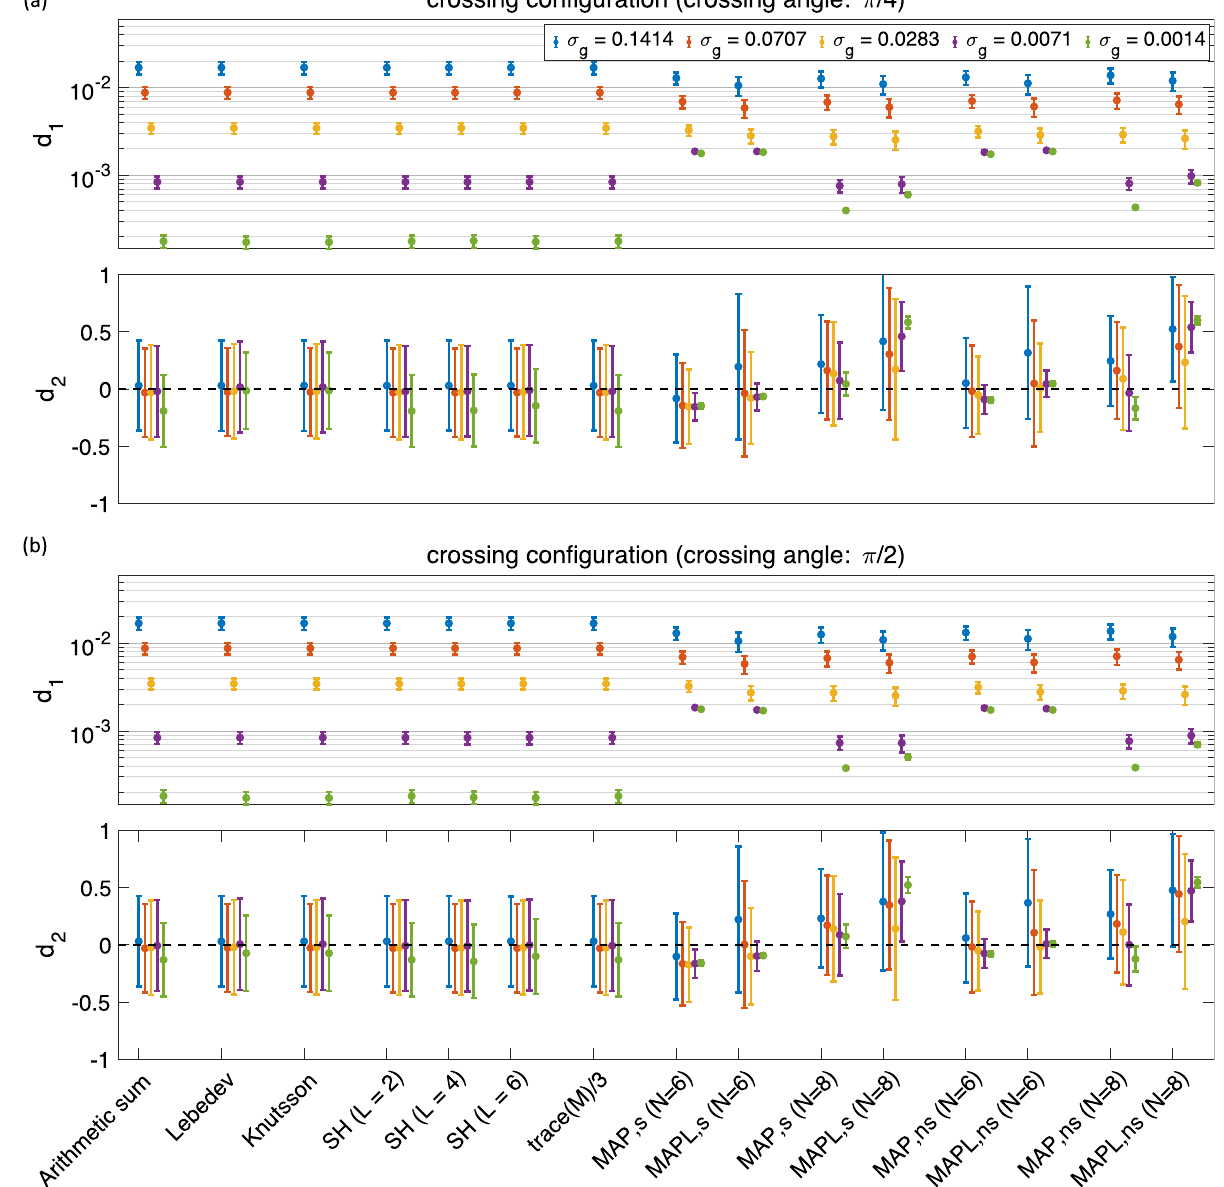
Figure 4. The mean and std of the d 1 and d 2 measures using different methods for 344 samples in the presence of crossing configuration with ( a ) π/ 4 and ( b ) π/ 2 radians crossing angle (the y-axis in d 1 is scaled logarithmically). The ‘s’ and ‘ns’ correspond to the shelled and non-shelled point sets, respectively. Different colors (blue, red, yellow, purple, green) show the results in different noise levels 0.1414, 0.0707, 0.0283, 0.0071, 0.0014 ( σ g =